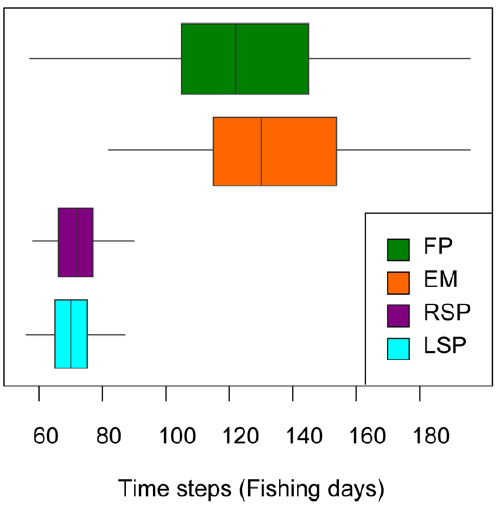
Figure 3. Harvesting efficiency (approximated by the fishing- trips needed to finish the simulation) related to the fisher behaviour. Box-plots of the harvesting efficiencies within 100 simulation runs until the virtual fish population collapsed to , 10% of the initial size: one fixed spot (FP, green), edge-based random movement (EM, orange), random search pattern (RSP, purple) and Le´vy search pattern (LSP, turquoise). The figure shows the box-plots of the days needed to overexploit the fish stock for each fisher style as a proxy of harvesting efficiency.